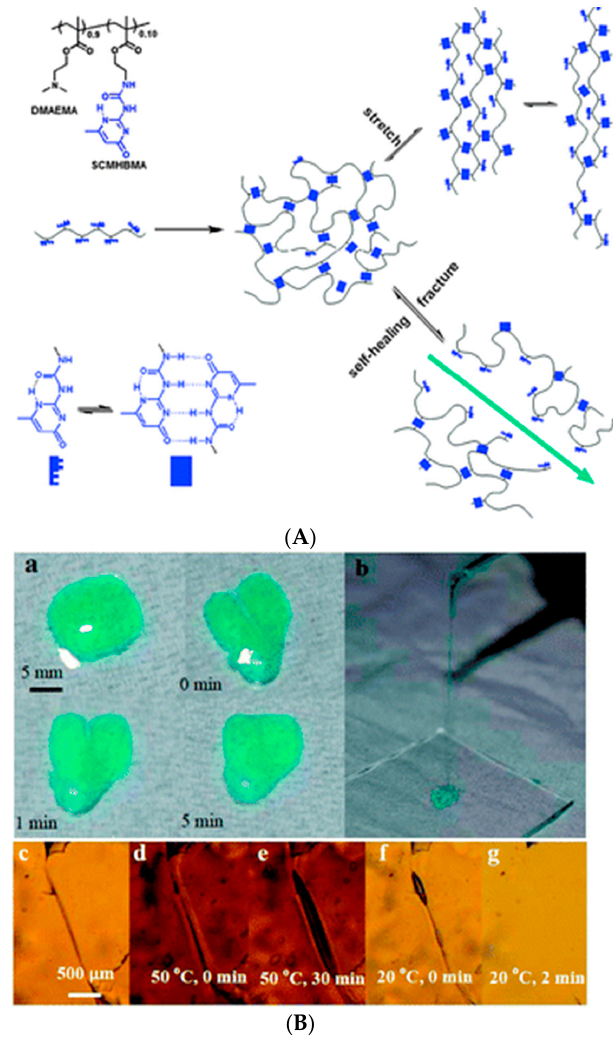
Figure 11. ( A ) Chemical structure of the copolymer containing DMAEMA and SCMHBMA and the schematic model of self-healing and stretching of the hydrogel formed by the copolymer; ( B